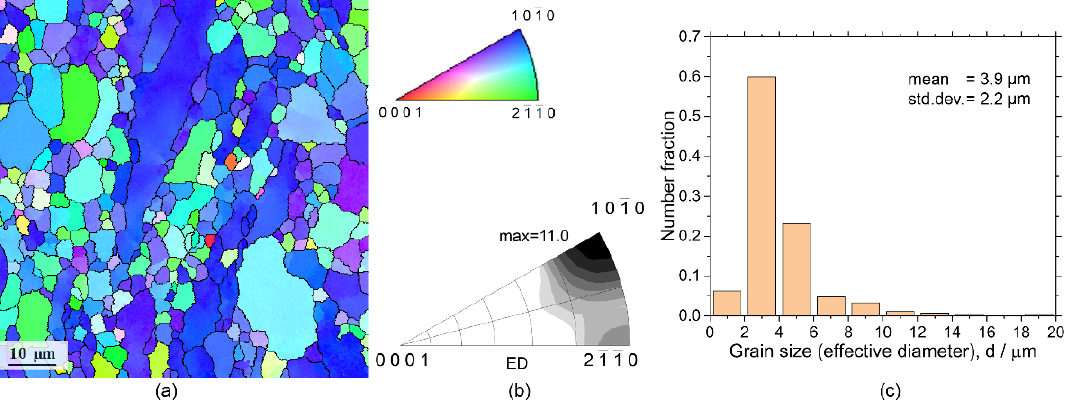
Figure 1. SEM-EBSD grain map ( a ) representing the typical microstructure of ZK60 alloy in the extrusion direction (ED), a crystallographic triangle with the inverse pole figure (IPF) colour codes applied to the grain map in ( a ) and the IPF ( b ), and the corresponding grain size distribution ( c ).